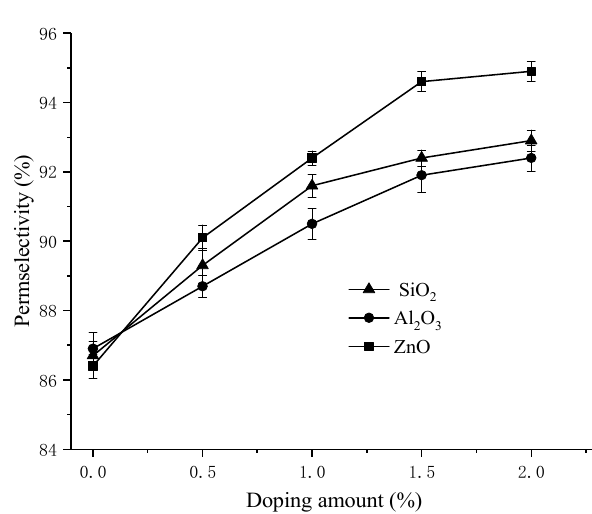
Figure 2. The effect on membrane permselectivity under different doping amounts of nano-SiO 2 , nano-Al 2 O 3 and nano-ZnO.